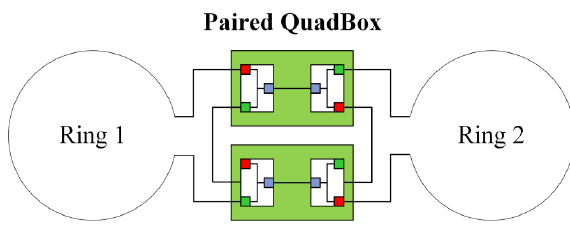
Figure 9. Paired QuadBox nodes connecting two